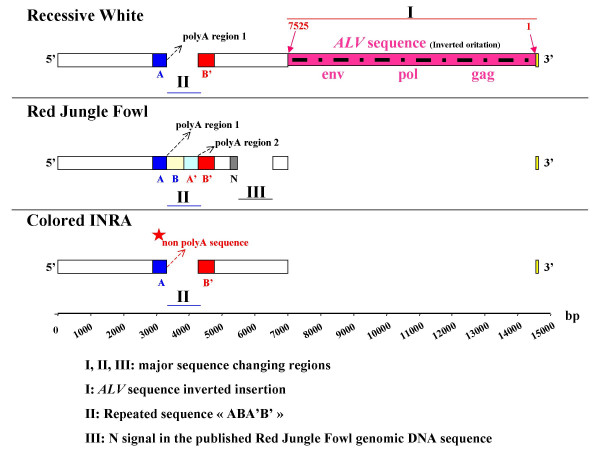
Comparative analysis of intron 4 sequence of the TYR gene of a recessive white chicken, a colored chicken and the Red Jungle Fowl. I: A complete ALV sequence was found in the recessive white chicken, inserted in the reverse orientation as compared to the usual ALV sequence numbered from 1 to 7525. II: A and A' or B and B' sequences respectively have up to 90% identity in the Red Jungle Fowl intron 4 sequence, and both A and A' sequences end by a polyA repeat (45 bp). Both of the recessive white and the wild type colored INRA chickens do not have B and A' sequences in their intron 4. The recessive white intron 4 "A" region contains the polyA sequence but not the "A" region of the wild type colored chicken intron 4. III: This region contains a stretch of N signals (chromosome 1: position 179546417–1795546627) in the published Red Jungle Fowl genome sequence that we were able to replace by a 1 kb informative sequence in both the recessive white and the wild type colored INRA chicken.